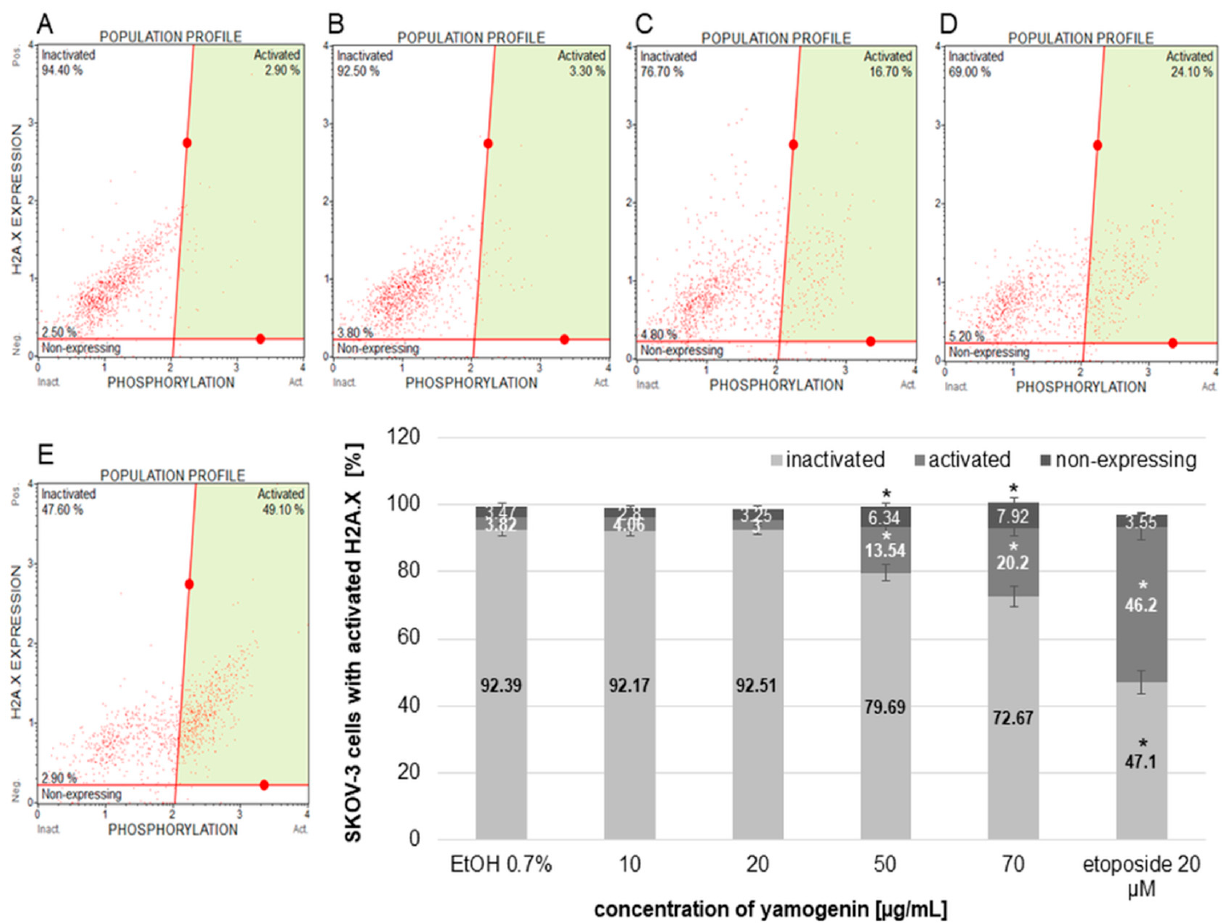
Figure 12. The activation of H2A.X in the SKOV-3 cells treated with yamogenin. The cells were incubated with ethanol (0.7% ( v / v )—a control, ( A )) and the compound at concentrations of 10, 20 ( B ), 50 ( C ), 70 µ g/mL ( D ), and etoposide ( E ) as a positive control for 24 h. The results were obtained with flow cytometry, and values represent the means ± SD obtained from three independent experiments. Error bars represent standard deviations. Significant differences relative to the control are marked with an asterisk (the Student’s t -test, * p < 0.05).